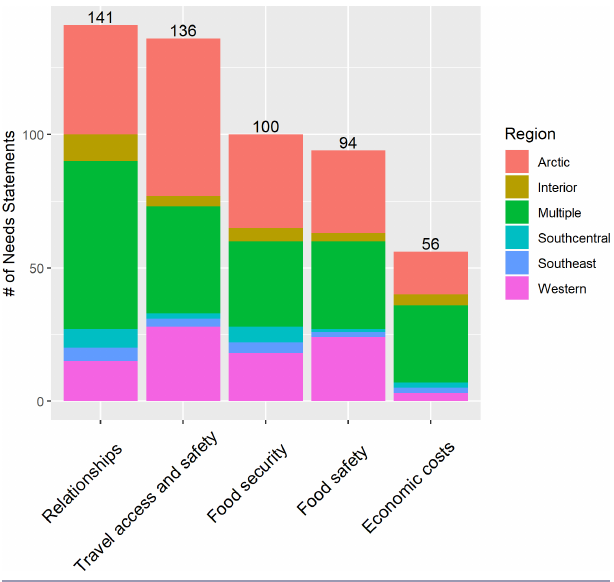
Fig. 5 . Stakeholder information needs related to socioeconomic conditions that result from unpredictable harvest (2008–2018).